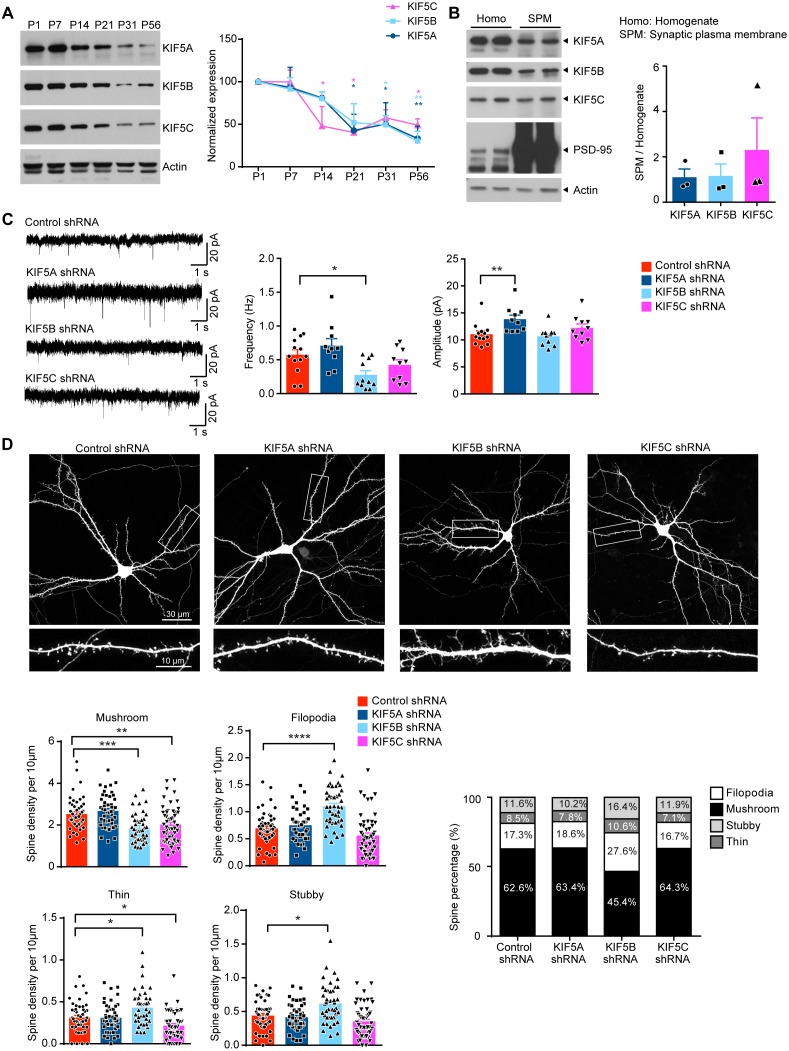
Different roles of KIF5s on dendritic spine morphogenesis and synaptic function.(A) Western blot showing the developmental expression of different Kinesin I motors in the mouse hippocampus. The expression of all three KIF5s significantly decreased at later postnatal stages as compared to postnatal day 1 (P1); three independent experiments, mean + SEM; *p<0.05; **p<0.01; Two way ANOVA with Dunnett's multiple comparisons test. (B) Presence of all three KIF5s in the synaptic plasma membrane (SPM). Postsynaptic density-95 (PSD-95) served as the positive control for the SPM fraction. (C) Whole-cell patch recording was performed on hippocampal neuron upon individually knocking down KIF5A, KIF5B or KIF5C with short hairpin RNAs (shRNAs). Representative traces of miniature excitatory postsynaptic currents (mEPSCs) were shown. KIF5B knockdown led to significant decrease in mEPSC frequency compared to control. KIF5A knock-down significantly increased mEPSC amplitude compared to control (n = 10–13 neurons for each condition from five independent experiments; mean + SEM; *p<0.05; **p<0.01; Kruskal-Wallis test). (D) Representative images of dissociated rat hippocampal neurons co-transfected with GFP and the shRNA targeting individual KIF5 or a control shRNA. Neurons were transfected at days in vitro (DIV) 13, and fixed and stained by GFP antibody at DIV 16. Knockdown of KIF5B significantly reduced the density of mushroom spines and led to a significant increase in the number of filopodia, thin and stubby spines. Knockdown of KIF5C significantly decreased the number of mushroom and thin spines (42–55 neurons of each group from three independent experiments were quantified; mean + SEM; *p<0.05, **p<0.01, ***p<0.001, ****p<0.0001; Kruskal-Wallis test).
Figure 1—source data 1.Plotted values for Figure 1.